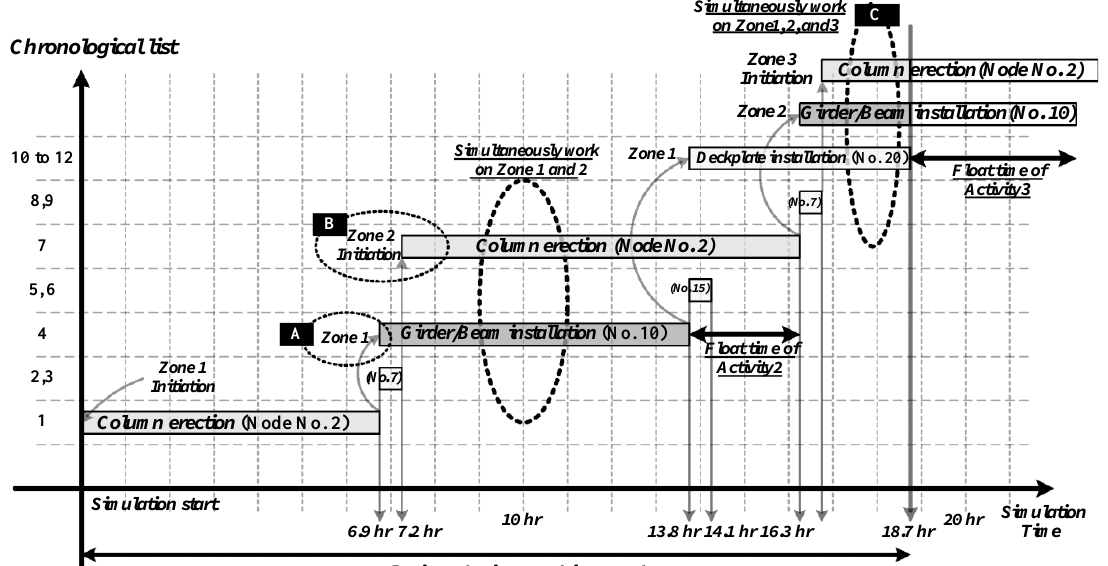
Fig. 5. Chronological lists by